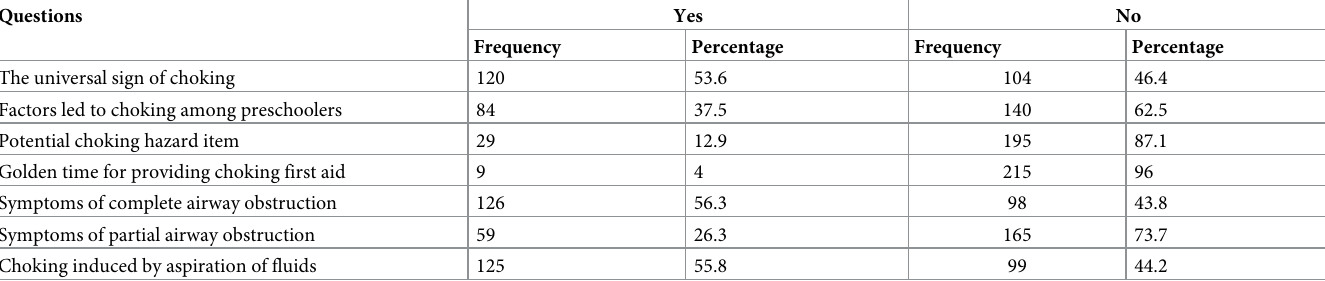
Table 2. Respondent’s answers frequency and percent for specific questions on knowledge aassessment in Addis Ababa, Ethiopia,